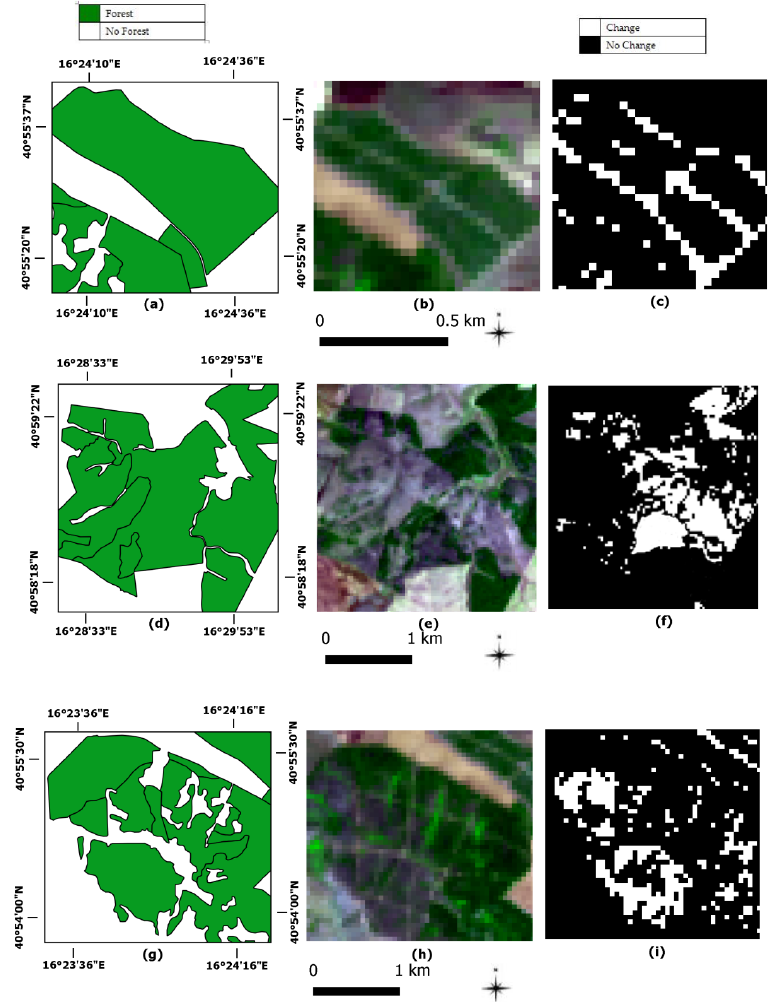
Figure 6 Figure 6. E xperiment 2.a—CCA_HR close-up areas from Figure 5, Italian site: ( a – c ) close-ups of the needle leaved forest shown in Figure 5c, blue circle; ( d – f ) close-ups of the broadleaved forest shown in Figure 5c, yellow circle; and ( g – i ) close ups of the mixed forest in Figure 5c, red circle, with changes probably due to